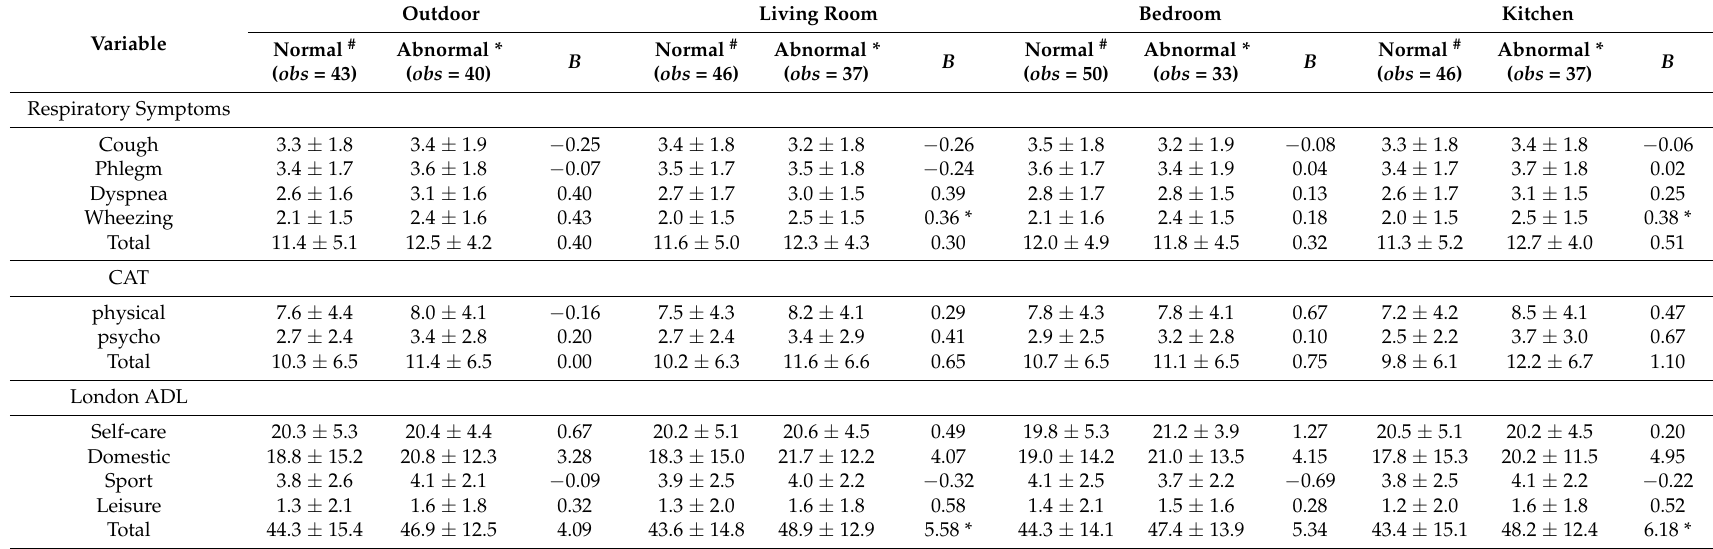
Table 3. Association between PM 10 and the symptoms and activities of daily living of COPD